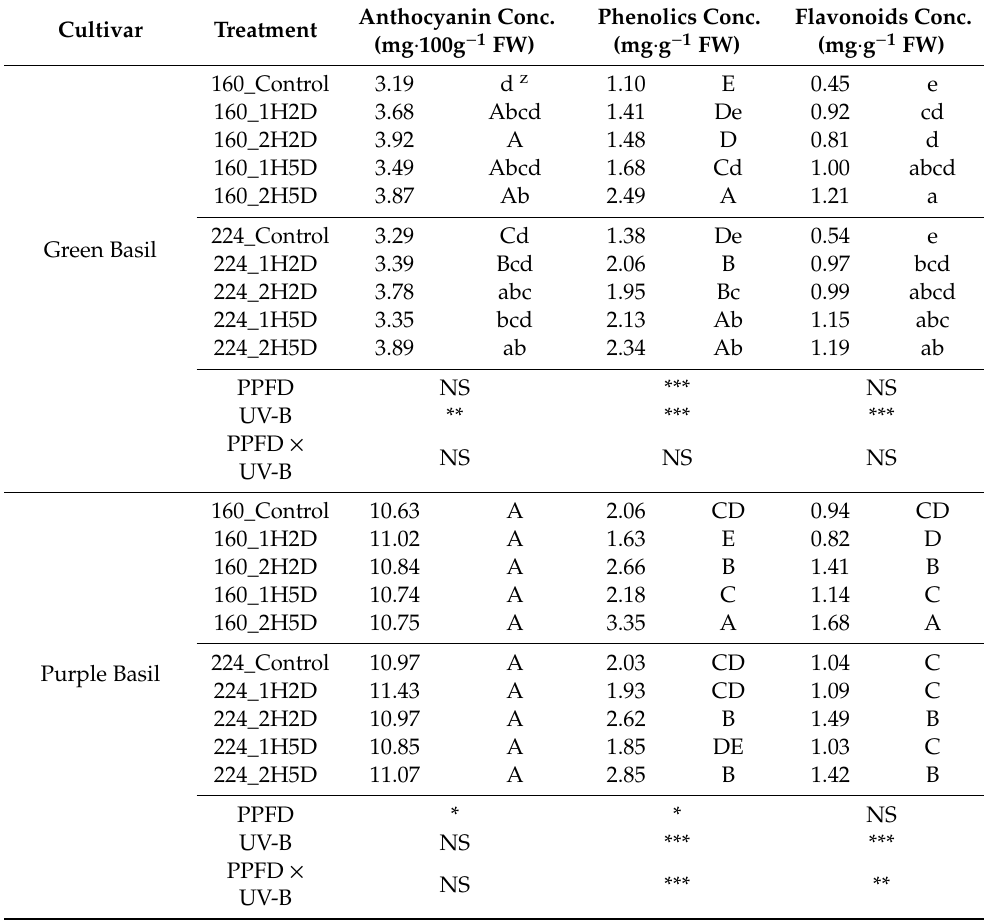
z Means followed by the same lower / upper case letters are not significantly di ff erent for green / purple basil plants, according to Student’s t mean comparison ( p < 0.05). Asterisks (*) indicate significant di ff erences (* p <